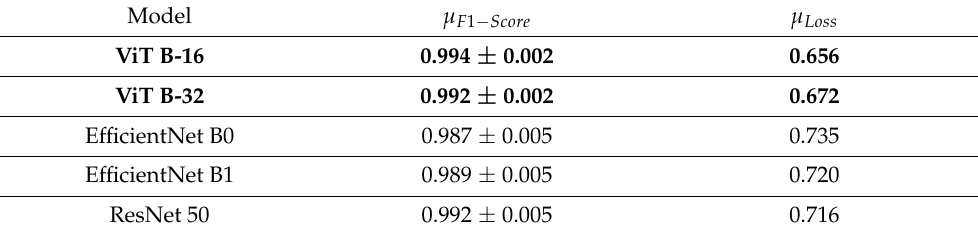
Table 2. Comparison between state-of-the-art CNN-based models and vision transformer models on agricultural image classification. The F1-Score has been calculated using Equation (10) with N =